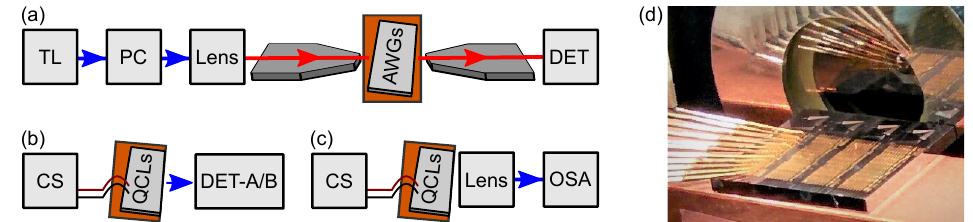
Figure 4. Experimental setups for ( a ) the AWG passive transmission, ( b ) the QCL LIV characteristics, and ( c ) the QCL spectral measurements. CS represents a current source and PC represents a polarization controller. ( d ) A photograph of the QCL array coupled to an AWG with the output collected by DET-A, corresponding to the schematic in ( b